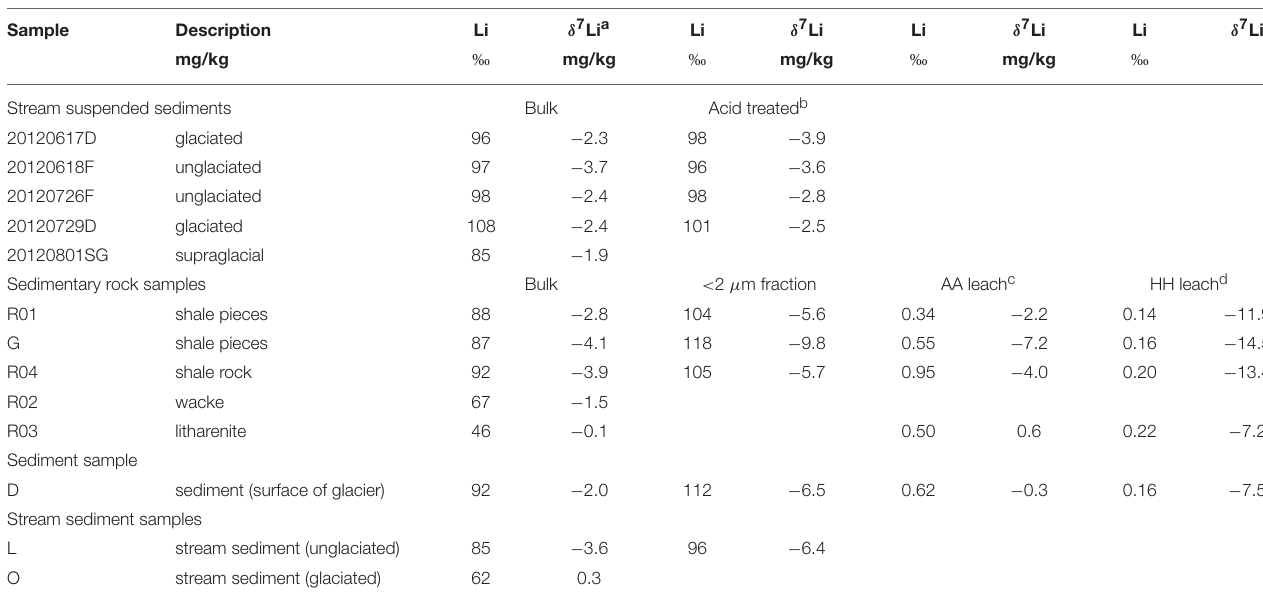
TABLE 3 | Li concentration and isotope data for solid